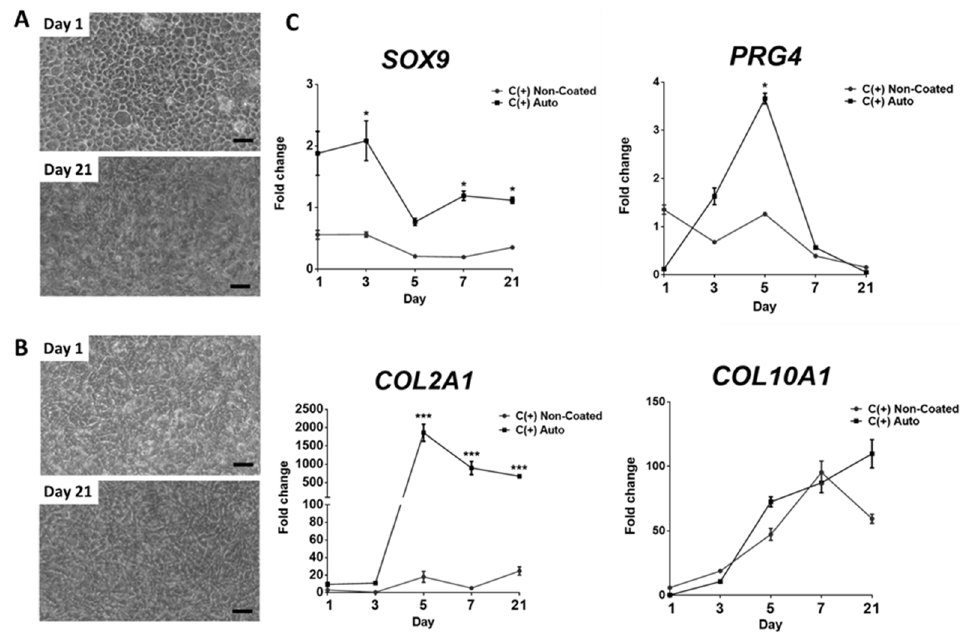
Figure 4. Progression of cell phenotype and gene expression over time in response to dcECM (Auto) coating. Brightfield microscopy images of hPDCs seeded at 100 × 10 3 per well and cultured in C(+) on ( A ) autoclaved dcECM-extract coating and ( B ) non-coated tissue culture plastic at day 1 and 21. Scale bar = 50 µm. ( C ) Chondrogenic gene expression ( SOX9 , PRG4 , COL2A1 and COL10A1 ). Cells were cultured for a period of 1, 3, 5, 7 and 21 days in Chondrogenic C(+) conditions on non- coasted or dcECM (Auto) coating ( n = 3 * p < 0.05, *** p < 0.001). (Fold changes normalised to cells in CTRL conditions). Statistical analysis was performed using one-way ANOVA corrected for multiple comparisons using Bonferroni’s post-hoc analysis.